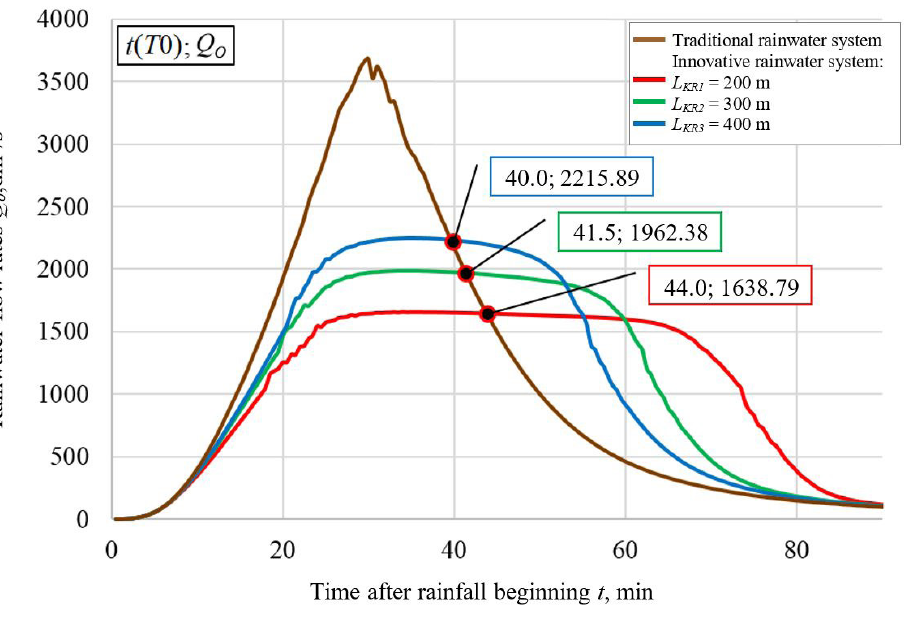
= 25 minutes, drainage d